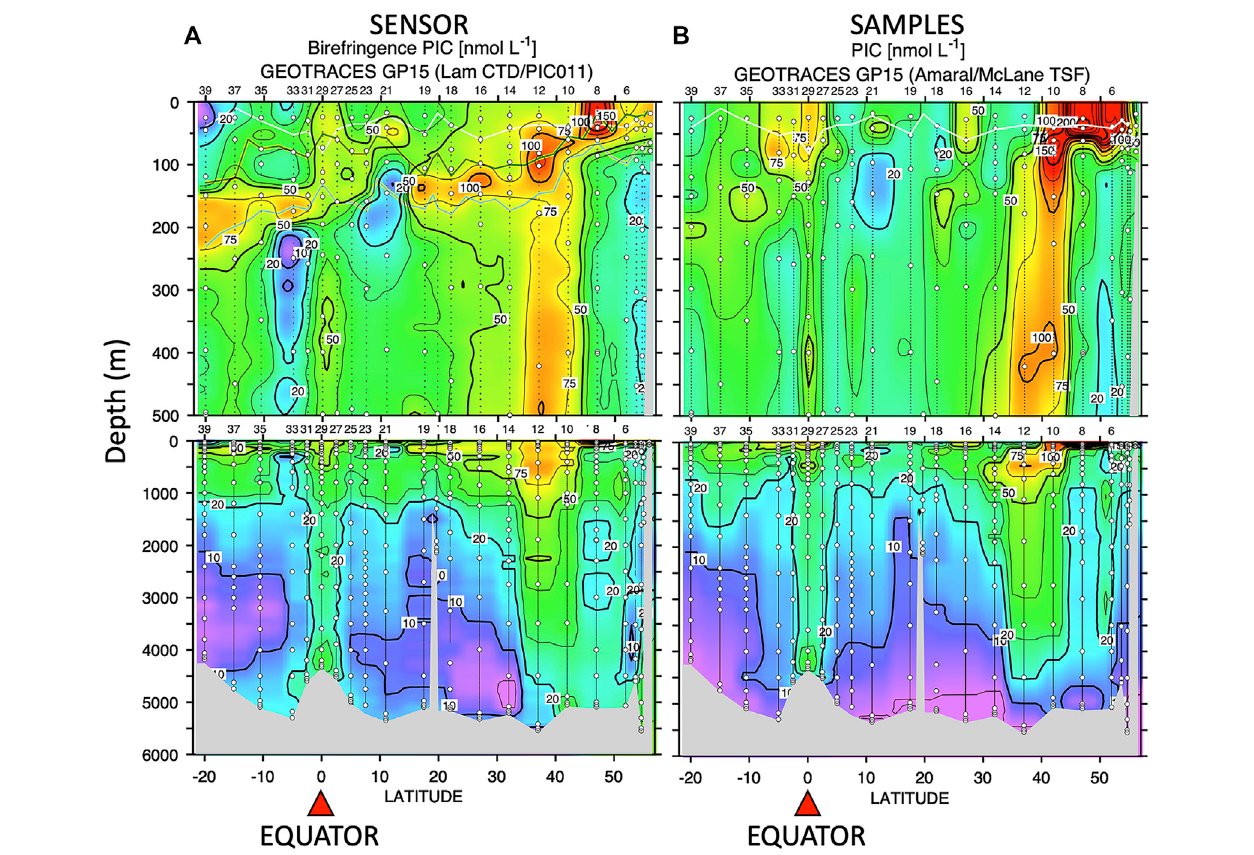
FIGURE8|(A) GP15transect section ofcalculated PIC concentration [nM] from birefringent photon yield measured byPIC011. Inpanel (A) thewhitelinedenotes mixed layer depth. The broad yellow/green curve denote the depth ofmaximum chlorophyll fl uorescence.The lower broad curvedenotes thebase of the euphotic zone (de fi ned by fl uorescence readings < 10% of maximum values, from Kenyon, pers. communication). The upper panels show an expanded 0 – 500 m depth range; lower panel shows the complete water column. White circles denote McLane pump sampling depths where measurements of PIC have been performed. (B) Transect sections for pump PIC [nM]. Color scales and contouring settings for all panels are